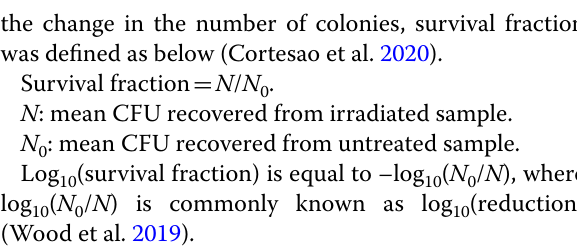
1 cm), B schematic of laser irradiation of a face ×